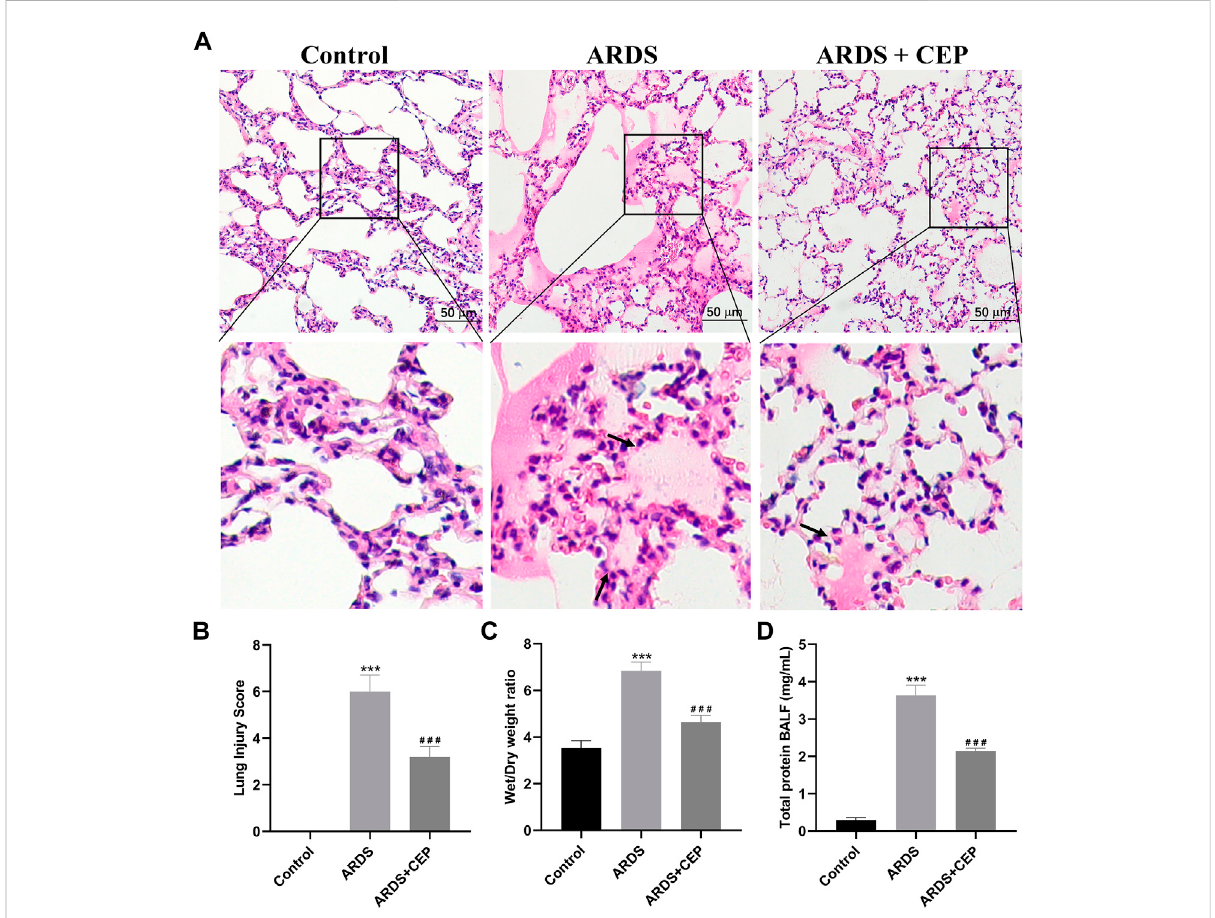
FIGURE 7 Evaluation of the CEP alleviation of oleic acid induced-ARDS lung injury in vivo . (A) Representative histological images of lung in each group (scale bar = 50 μ m). Arrows represent exudative lesions and bleeding. (B) Lung injury scores according to the degree of lung damage in each group. (C) Wet/Dry weight ratios of lungs as an index of lung edema. (D) Total protein concentration in the BALF. Data are presented as the mean ± SD. *** p < 0.001, compared with the Control group; ### p < 0.001, compared with the ARDS